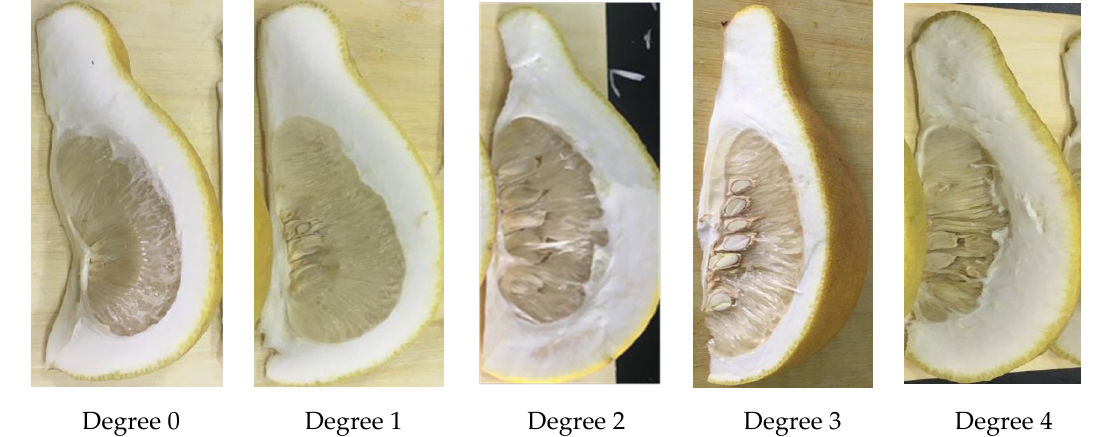
Figure 2. Pomelo sections with different granulation degrees.